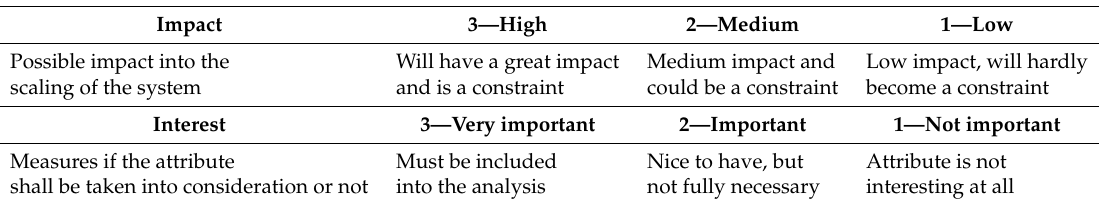
Table 2. Explanation of the scaling system used for determining the interest and impact of the attributes selected for any given scenario under study.